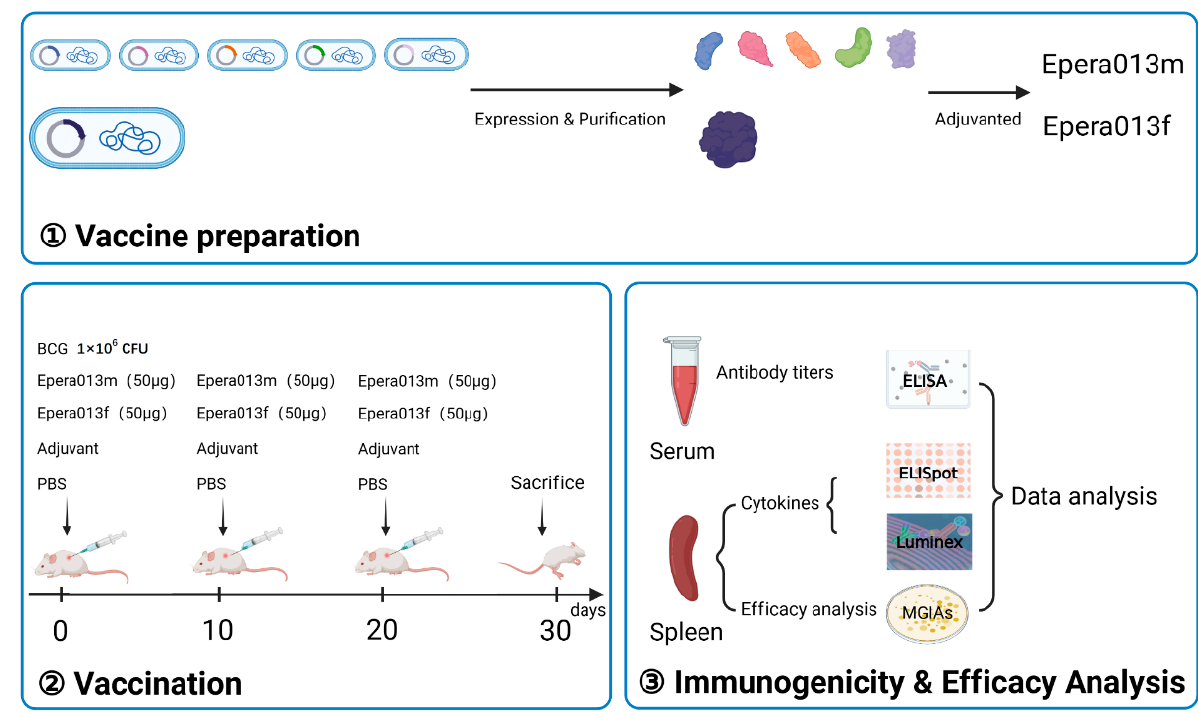
Figure 1. Schematic diagram of experimental design and procedures of the immunogenicity and efficacy evaluation of Epera013, Epera013m and BCG. CFU, colony forming unit; ELISA, enzyme linked immunosorbent assay; Elispot, enzyme linked immunospot assay; MGIAs, mycobacterium growth inhibition assays.